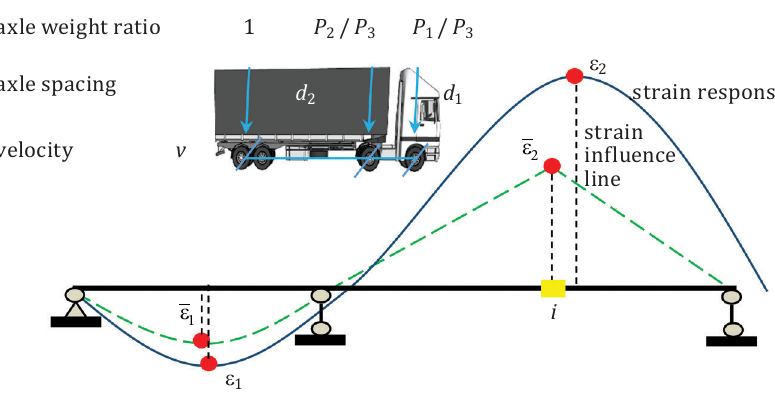
Figure 2. Strain response induced by a moving